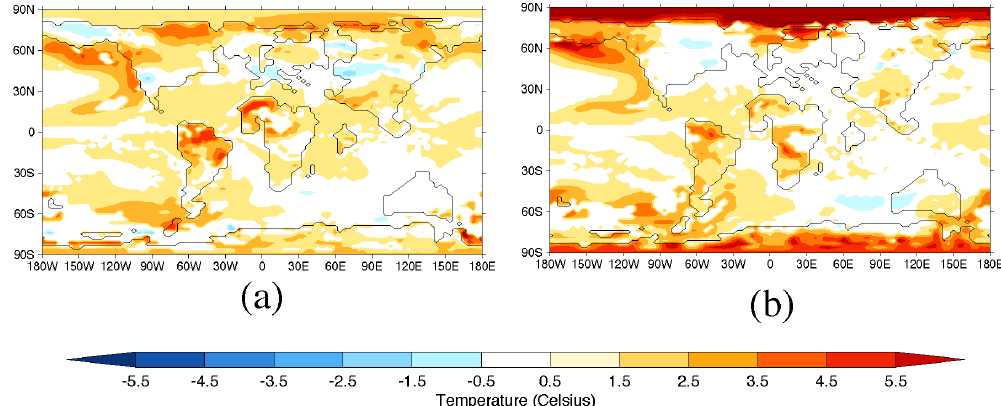
Fig. 14. The effect of dynamic vegetation on the surface air temperature increase when CO 2 is doubled (i.e. 4 × DYN − 2 × DYN) − (4 × SHRUB − 2 × SHRUB) (a) in JJA and (b) in DJF. Only differences at the 95% confidence level are